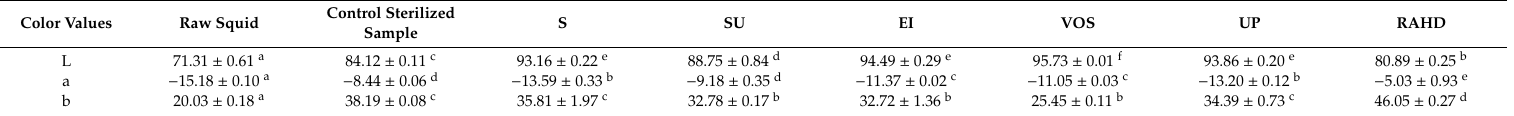
Table 6. Color of neritic squid muscle treated by di ff erent softening methods, versus raw and untreated controls.